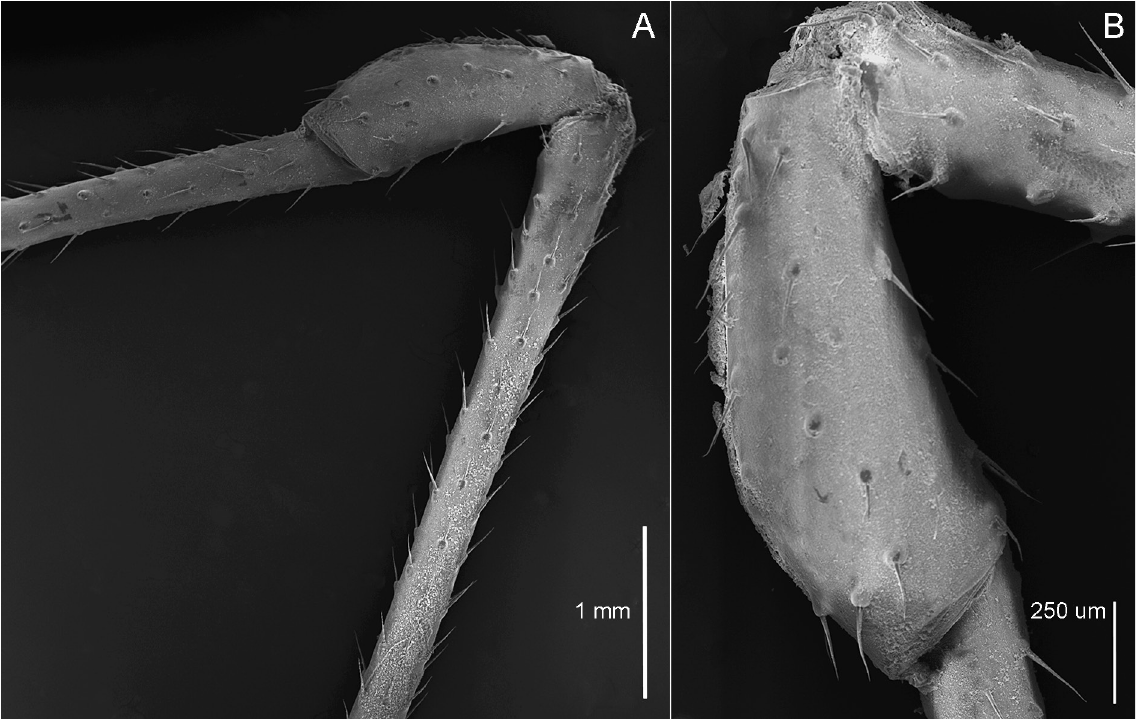
Fig. 2. Troglostygnopsis anophthalma Šilhavý, 1974, ♂, topotype (AMNH). A . Apical femur, patella and basal tibia IV. B . Patella